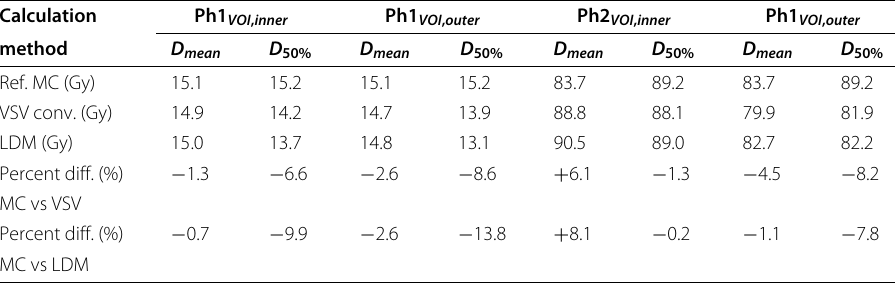
Table 3 Comparison of absorbed dose calculation methods through the D mean and D 50% for Ph1 at 0.29 MBq mL − 1 and Ph2 at 1.71 MBq mL − 1 , for both VOI outer and VOI inner . Reconstructions